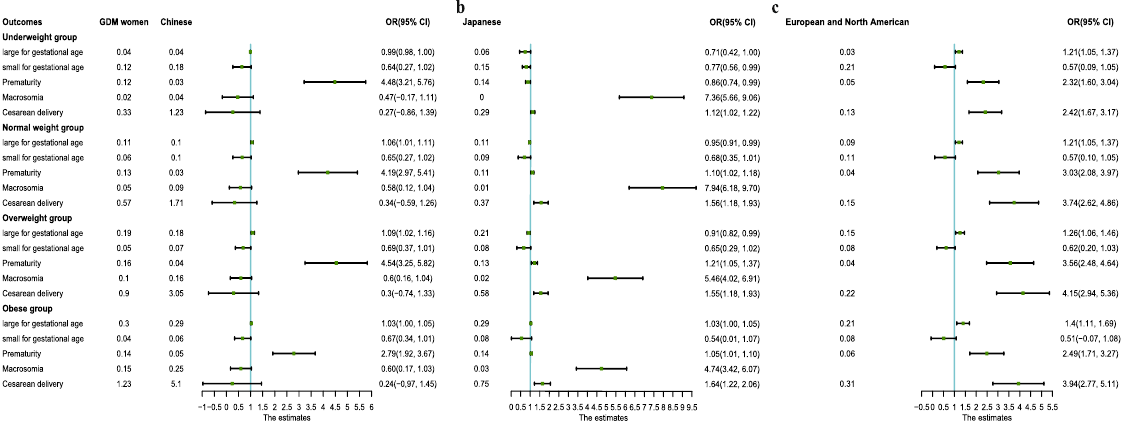
Figure 4. Meta-analysis of the associations of maternal-infant adverse outcomes with pre-pregnancy BMI in three independent cohorts. ( a ) Forest plot showed the different adverse outcomes between women with GDM and normal Chinese women in four pre-pregnancy BMI subgroups. ( b ) The different adverse outcomes between women with GDM and Japanese women in four pre-pregnancy BMI subgroups were compared. ( c ) Compared with Chinese GDM women, the incidences of adverse outcomes in European and North American women were